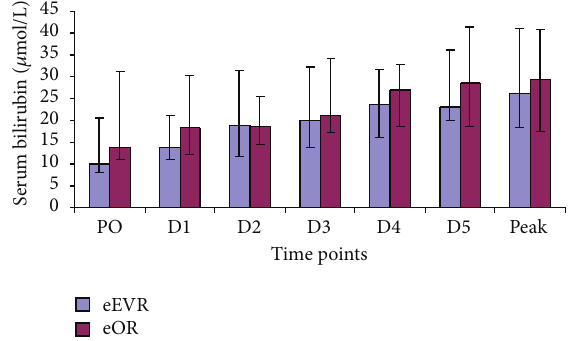
Figure 5: Serum bilirubin concentrations expressed as median and IQR (Mann-Whitney 𝑈 test).